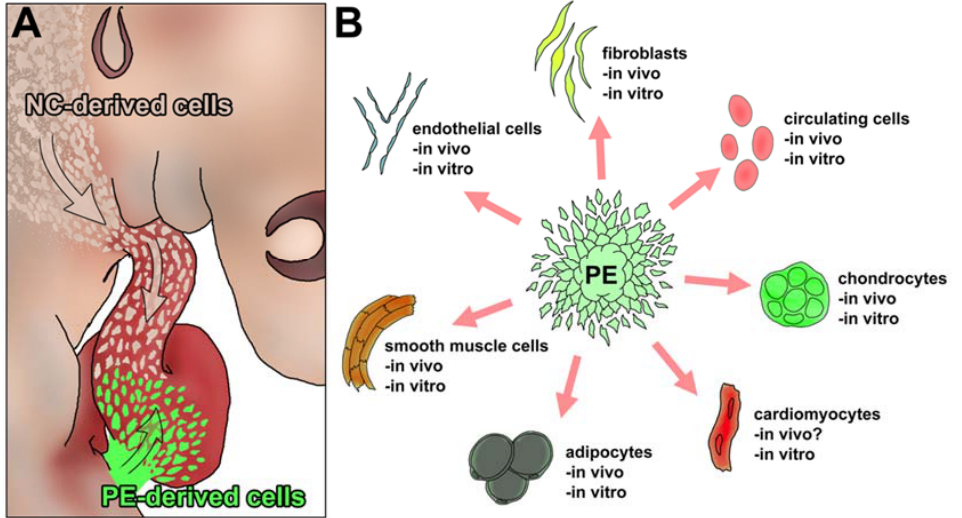
Figure 3. Schematic illustration of the in vivo and in vitro differentiation potential of the proepicardium. ( A ) A model for the integration of different cardiac chondrogenic cell population is shown. ( B ) Schematic illustration showing different reports of in vivo and in vitro differentiation of proepicardial (PE) derived cells into different cell types. These cell types include fibroblasts [31–35], circulating cells [43,44], cardiomyocytes [37–42], adipocytes [36], smooth muscle [29–31] and endothelial cells [25–28]. In this publication we report the differentiation potential of the PE both in vivo and in vitro. PE: proepicardium.